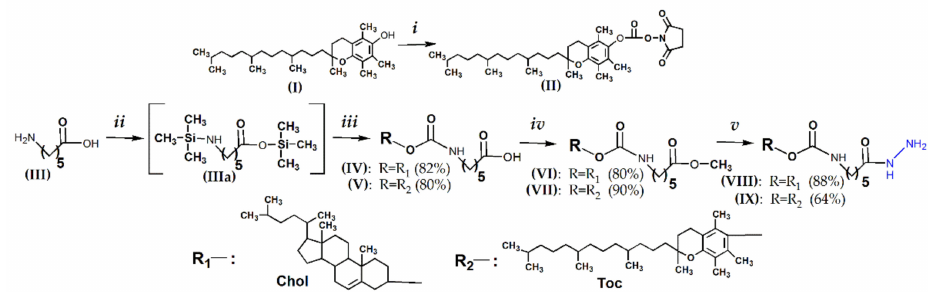
Figure 2. General scheme of the synthesis of hydrazides of cholesterol ( VIII ) and α -tocopherol ( IX ). Reagents: ( i ) DSC, CH 2 Cl 2 , CH 3 CN, triethylamine (TEA), room temperature (RT); ( ii ) (CH 3 ) 3 SiCl, pyridine (Py), 4 ◦ C; ( iii ) CholOC(O)Cl or N -succinimide derivative of α -tocopherol ( II ), Py, RT; 0.7 M HCl; ( iv ) PCl 3 , CH 2 Cl 2 , argon, RT; CH 3 OH abs, RT; and ( v ) NH 2 NH 2 • H 2 O, CH 3 OH,